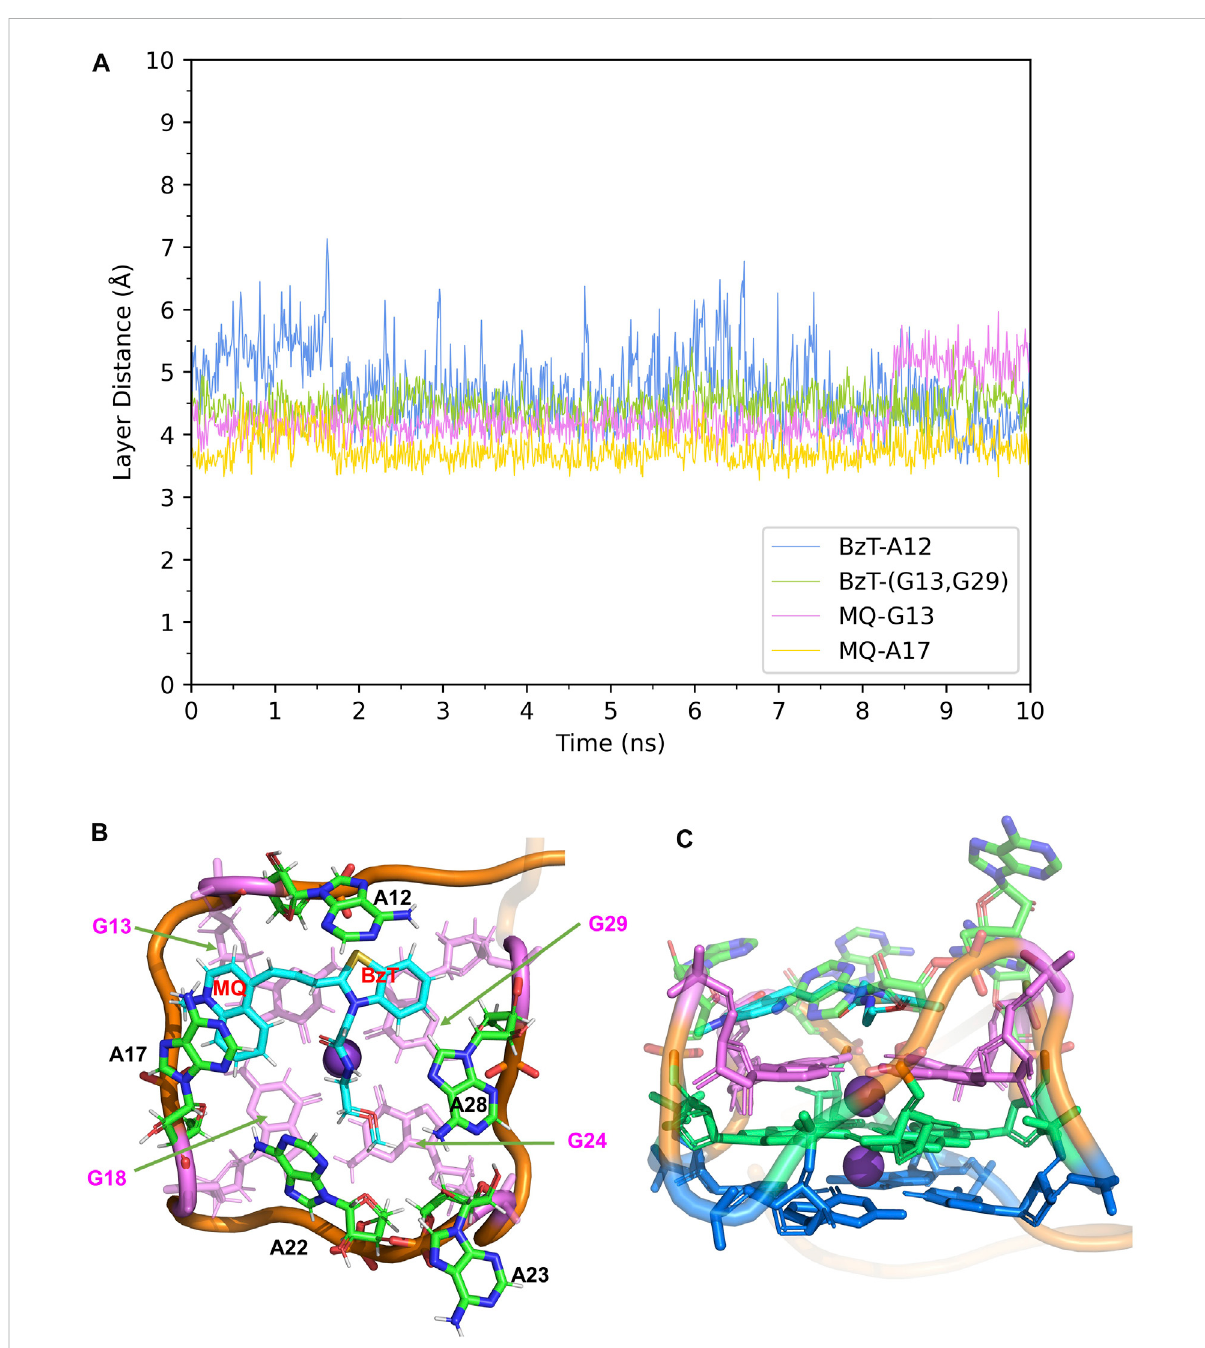
FIGURE 5 Structural analysis of MD simulation on wild-type Mango-II with TO3-Biotin. (A) : the trajectories of important structural parameters in the MD process. (B) :thetopviewofequilibriumstructurefromtheMDprocess(4 nssnapshot),withtheligandshownincyanandT3guaninesshowninpink. (C) : the side